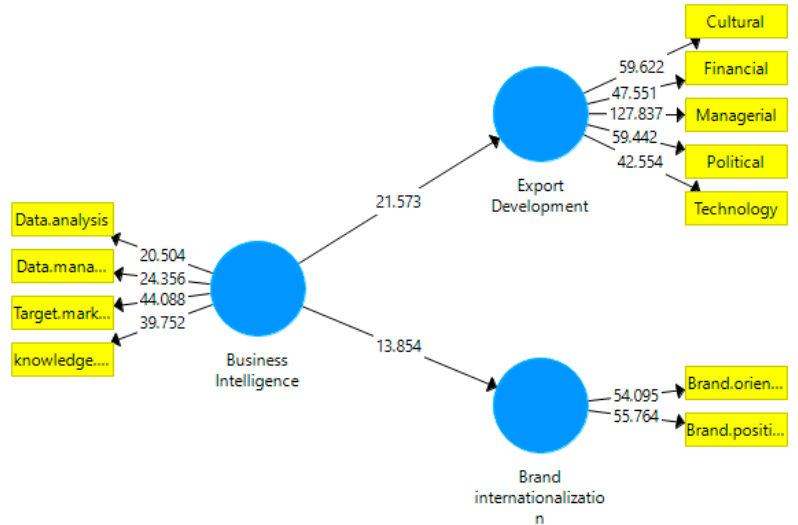
Figure 3. T-values for the effect of applying business intelligence on export development and brand internationalization in large industrial firms.